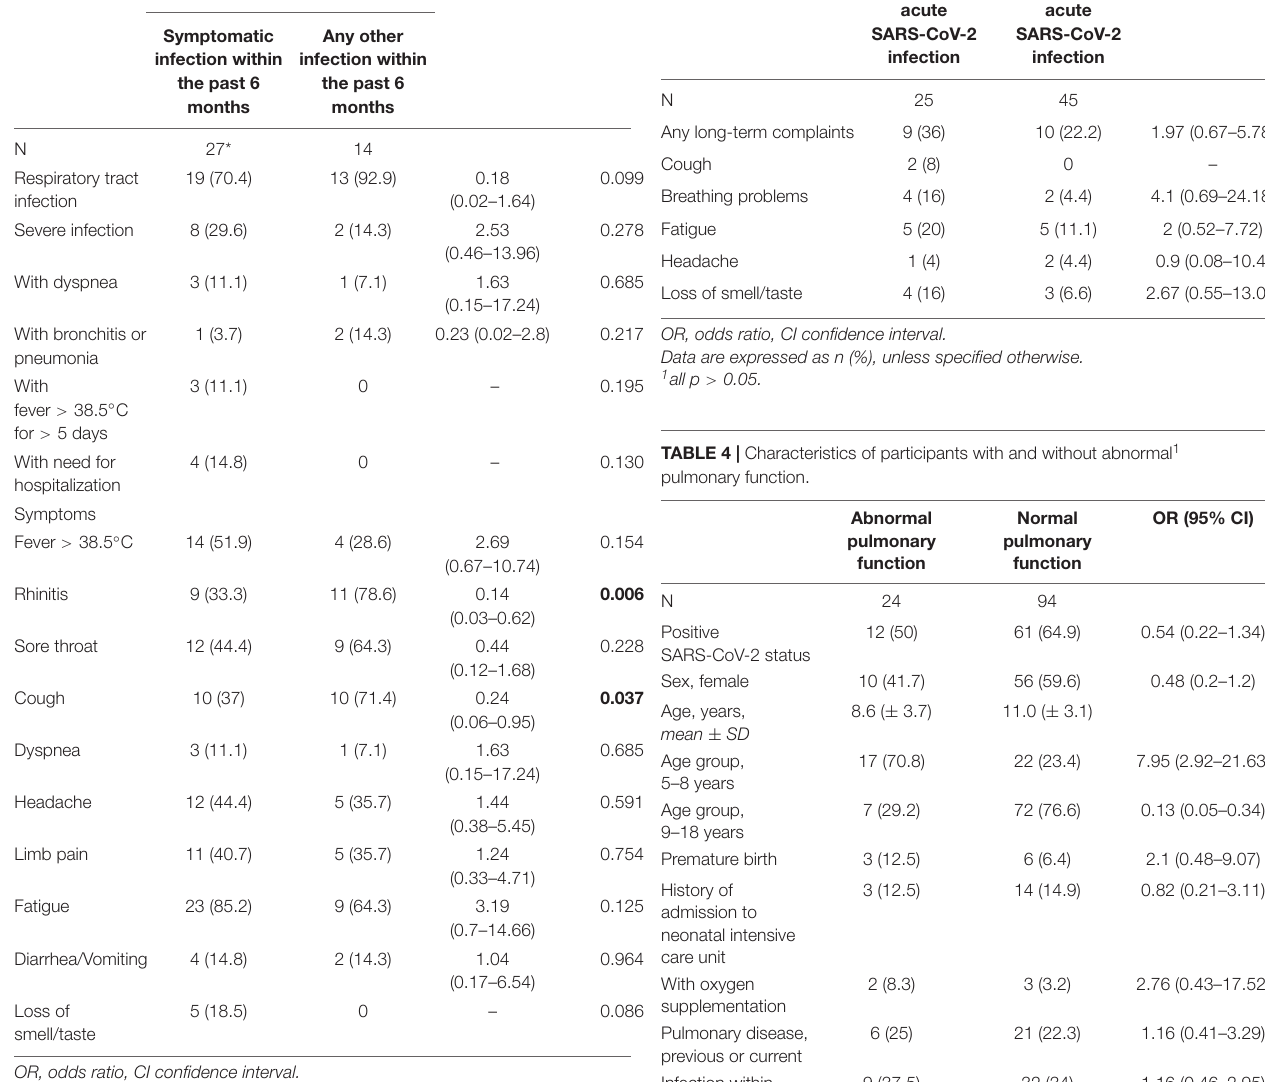
TABLE 2 | Infection characteristics. TABLE 3 | Long-term complaints in children and adolescents with symptomatic and asymptomatic acute SARS-CoV-2 infection.